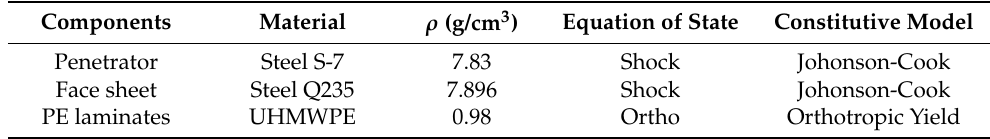
Table 3. Material models used in numerical simulation.